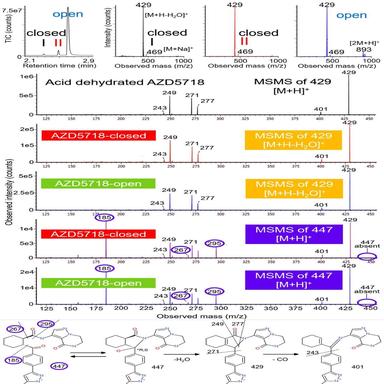
Top panel: LCMS of AZD5718 followed by mass spectra of the three tautomers. All show the same ease to lose water, besides minor Na-adducts and dimers, illustrating the rapid ring-closure followed by de-watering in the ion source. Next three spectra are all MSMS of m/z = 429: first wet-chemically dehydrated AZD5718, then the LCseparated closed and open forms, dehydrated in the ion source giving m/z = 429, followed by MSMS of this fragment. The following two spectra show MSMS of +, m/z = 447, both the open an